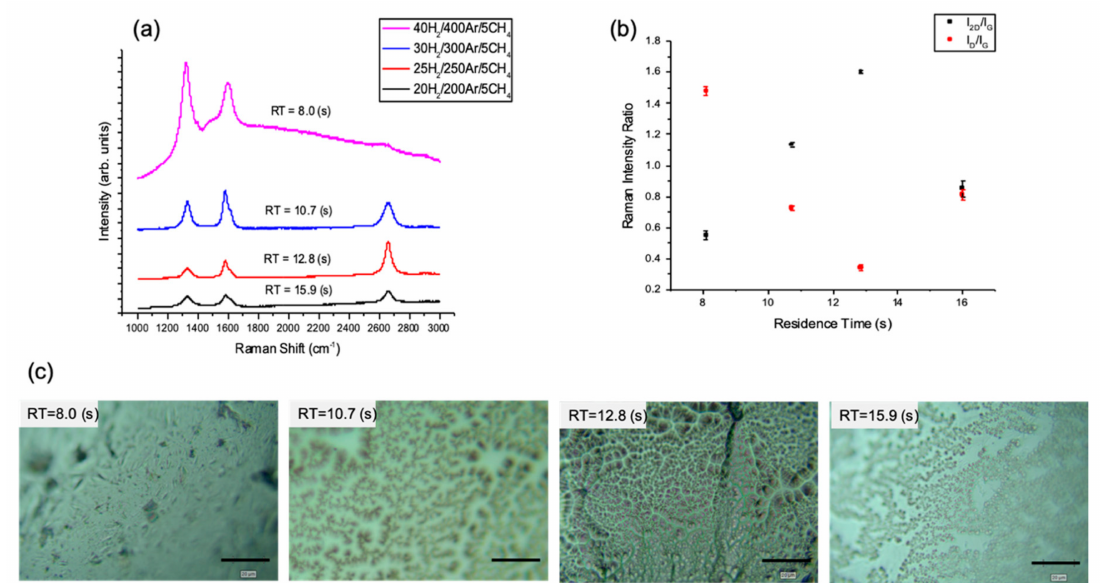
Figure 1. ( a ) Typical Raman spectra of the APCVD graphene grown on liquid Sn for di ff erent residence times (RTs) and H 2 :CH 4 ratios. ( b ) Average Raman peaks intensity ratios I 2D / I G and I D / I G with respect to residence time. (Error bars are smaller than some data points.) ( c ) Optical images of the grown graphene films (scale bar: 20 µ m), some blurriness is due to the surface curvature of the solidified Sn after melting. (APCVD, T = 1120 ◦ C, (20–40) H 2 / (200–400) Ar / 5 CH 4 sccm, t = 5